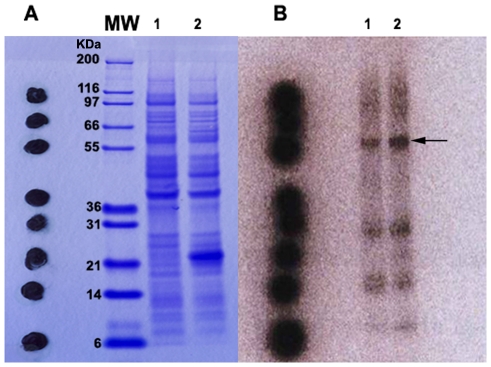
Analysis of isotope 75Se-cysteine incorporation.(A) Profile of expressed protein products on a 12% SDS-PAGE gel. (B) Autoradiogram profile of expressed products corresponding to the proteins on SDS-PAGE. Lane 1: Expression products of E.coli BL21 containing plasmid SjTGR-pET41a. Lane 2: Expression products of E.coli BL21 containing plasmids SjTGR-pET41a and pSUABC. MW: Protein molecular weight marker. The black dots on the SDS-PAGE gel are the expression products of E.coli BL21 containing plasmids SjTGR-pET41a and pSUABC. The expression products containing isotope 75Se-cysteine (SeCys) were dotted on the SDS-PAGE gel after electrophoresis as a positive control for autoradiography. The black arrow indicates the SjTGR selenoprotein developed by autoradiography.